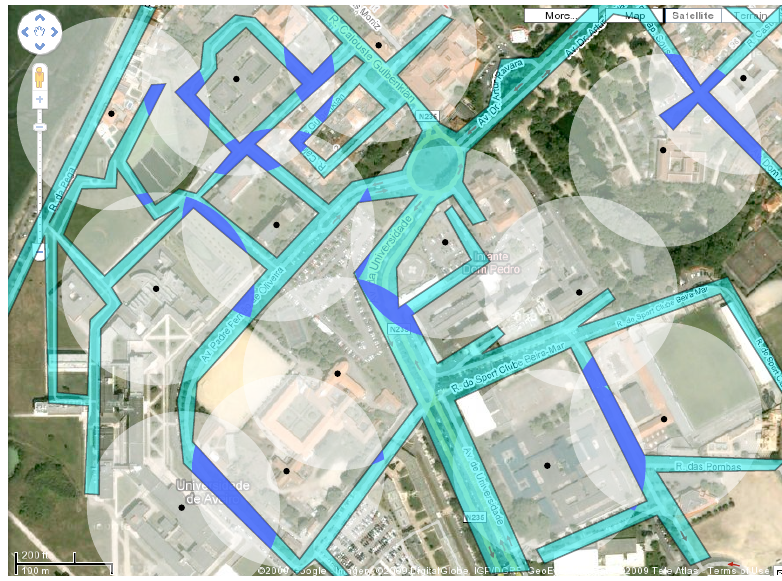
Figure 2. The areas of the polygonal region that are covered by at least two antennas are shown in dark blue.